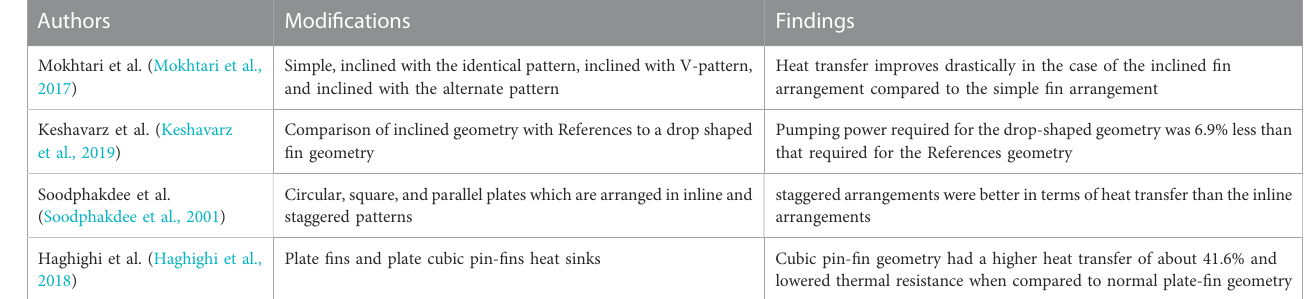
TABLE 1 Summary of work on fi n geometris and arrangements.